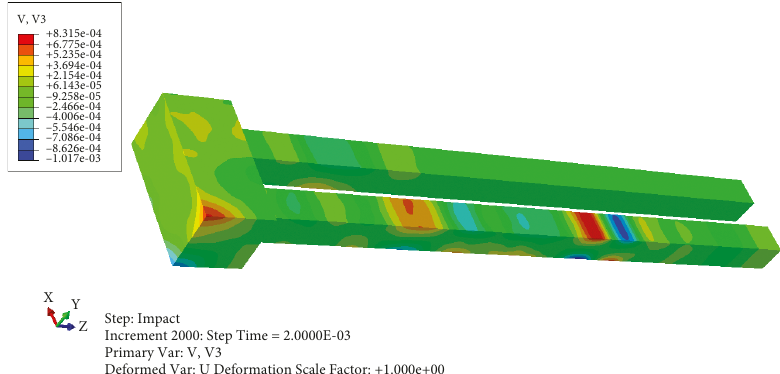
Figure 6: Abaqus model (time t